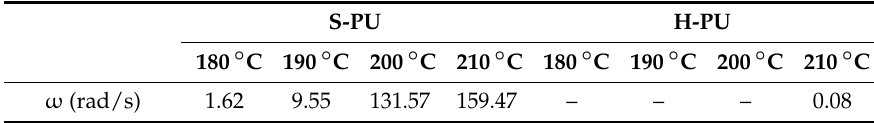
Table 3. Angular frequencies of G (cid:48) -to- G ” crossover in S-PU and H-PU at different temperatures.